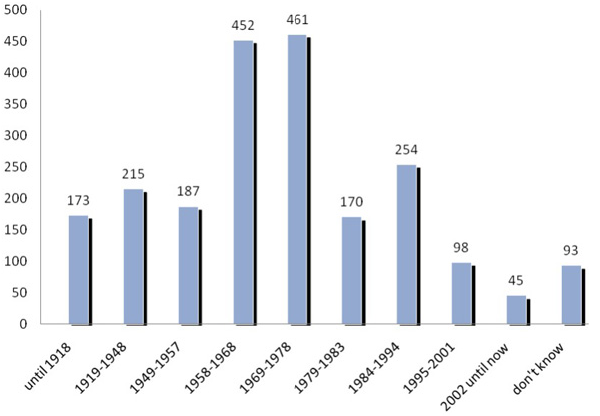
Figure 5. Numbers of buildings in di ff erent ages in